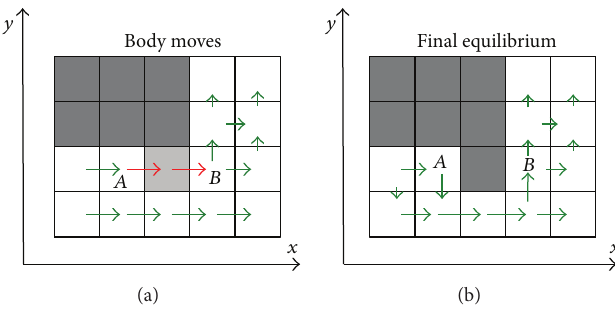
Figure 7: Top view of an aliasing problem. A body (dark gray) is staying in a stable current. Arrows show the flow between cells. The blocker slightly moves to occupy a new cell (light gray), causing the red flows to instantly become blocked. Cell 𝐴 now has much more inflow than outflow, which causes a sharp peak in the surface before the flows settle down to a new equilibrium (on (b)). Similarly, the surface in 𝐵 will suddenly drop. Both of these cause large waves to emanate from the